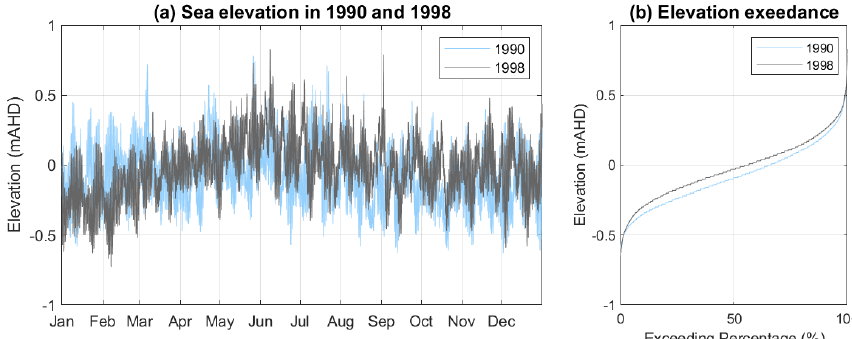
Figure 4. (a) Sea level changes and (b) their exceedance plot in the years 1990 and 1998.